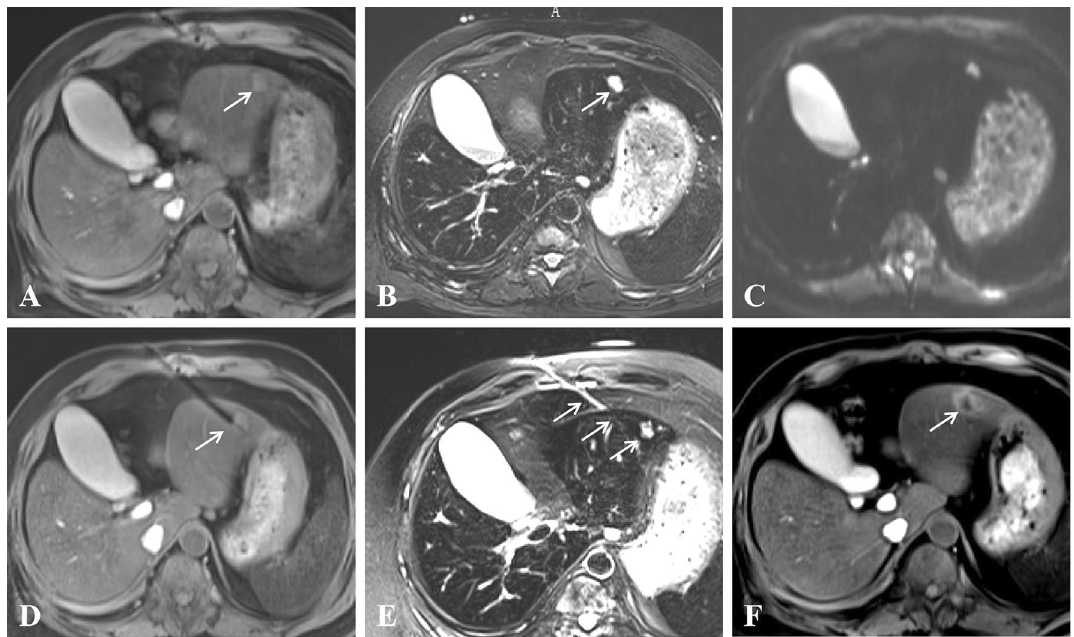
Figure 3. A 66-year-old man with liver metastasis at segment 3 (primary diagnosis was rectal carcinoma and underwent surgical resection). ( A – C ) Pretreatment MR showed a small lesion (diameter = 1.3 cm) on T1WI ( A ), T2WI ( B ) and DWI ( C ); ( D , E ) Lesion was punctured by a microwave applicator on T1WI ( D ) and T2WI ( E ), and high signal exudation associated with puncture directed by white arrows on Figure ( E ); ( F ) T1WI showed that the ablation focus was ellipsoidal with a high signal, which means complete